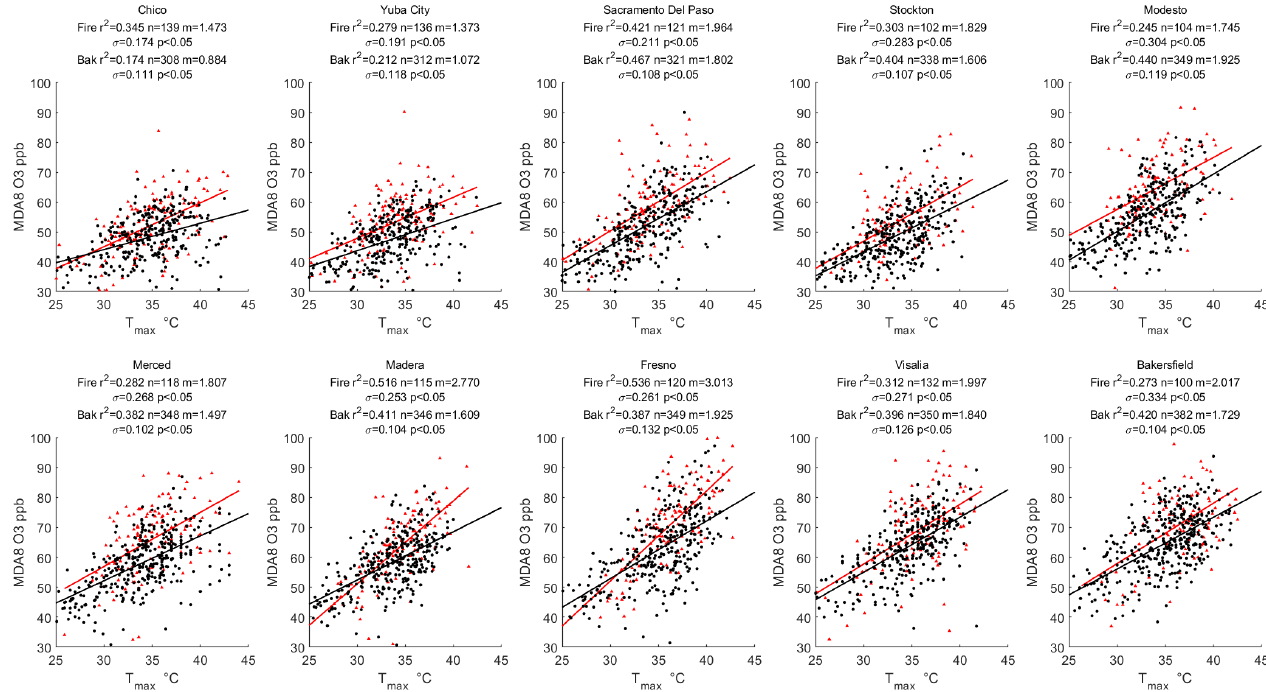
Figure B2. Scatter plot and linear regression for daily maximum temperature vs. MDA8 O 3 at each site for wildfire periods (red) and background periods (black). The R 2 above each figure is the coefficient of determination, m is the slope or enhancement ratio, n is the number of data points in the regression, σ is the standard error for the linear regression, and p is the P value that represents the rejection of null